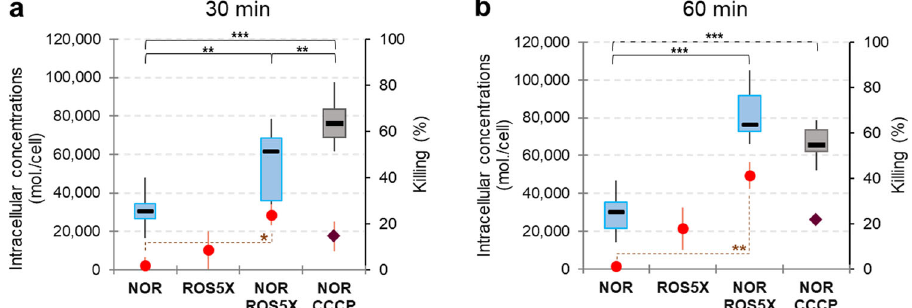
Fig. 4 Cooperative killing rates of the ROS – NOR combination. NOR accumulation (molecules.cell − 1 ) and cell killing rates (red points) measured during incubation of EA27 with NOR at 16 µ M, without or with 20 µ M CCCP, or with ROS 5X. Bacterial suspensions were sampled at 30 ( a ) and 60 minutes ( b ) for spectro fl uorimetric measurement of NOR accumulation (boxplot) and for CFU determination. Cell killing rates were calculated from CFU and represented as means± SD ( n = 3 independent experiments). Kruskal-Wallis with Dunn tests were used to determine differences of NOR accumulation ( n = 3 independent experiments) at 30 minutes ( η ² = 0.79) and 60 minutes ( η ² = 0.42). ANOVAs with Tukey post hoc tests were used to determine differences of killing rates at 30 min (F(3,8) = 4.9, P = 0.0327) and 60 minutes (F(3,8) = 7.33, P = 0.011). *** P < 0.001; ** P < 0.01; * P <